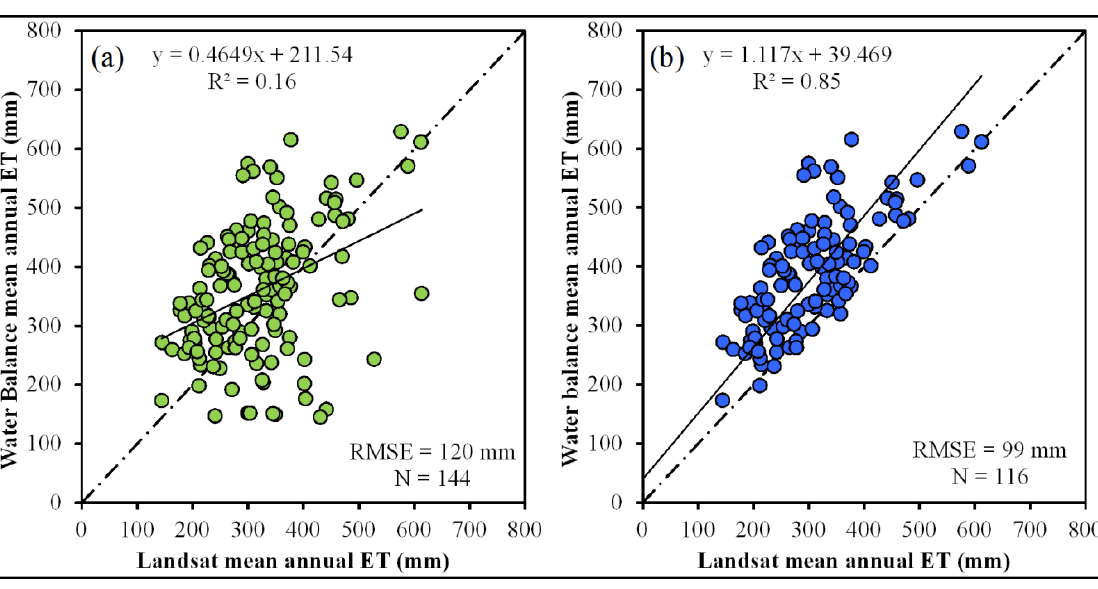
Figure 8. Comparison of mean annual evapotranspiration based on water balance (Precipitation–runoff) and Landsat-based mean annual evapotranspiration for ( a ) all HUC8 sub-basins; and ( b ) HUC8 sub-basins meeting three criteria: precipitation > runoff, Evapotranspiration < precipitation, and runoff coefficient (Q/P) <